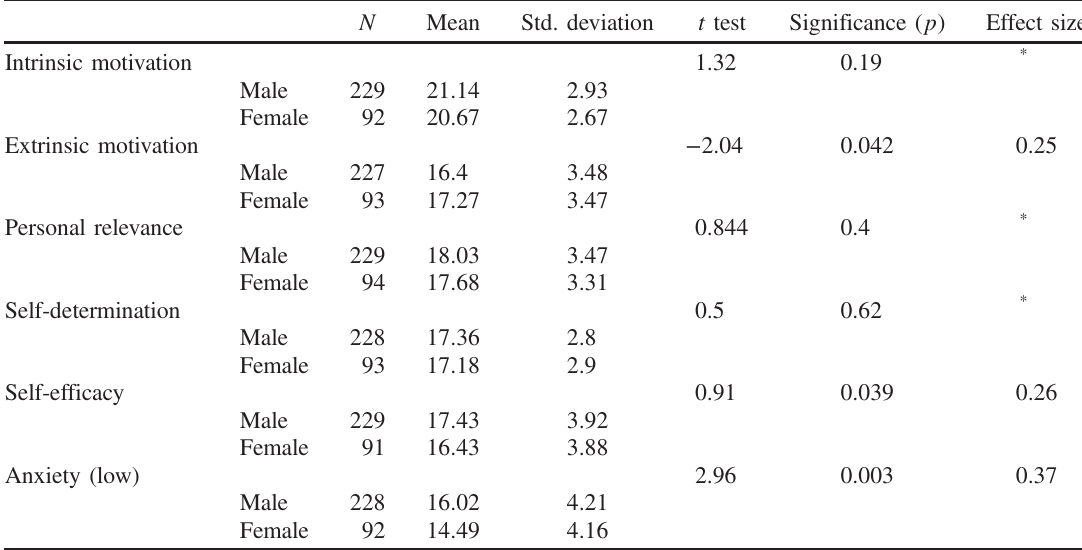
TABLE VI. Motivation factors by gender.